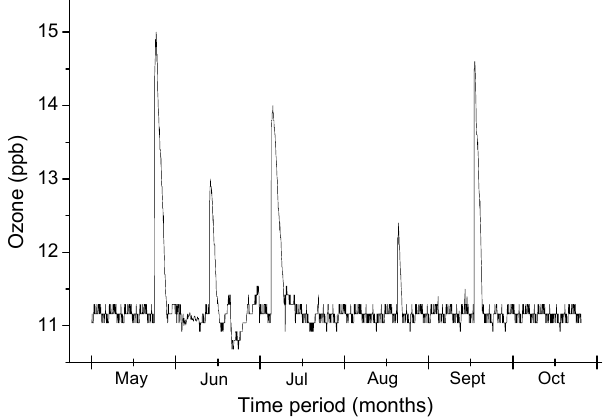
Figure 14. Ozone level received from the MSMN node.